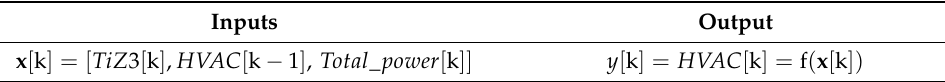
Table 1. Input–output pair of Experiment 1.